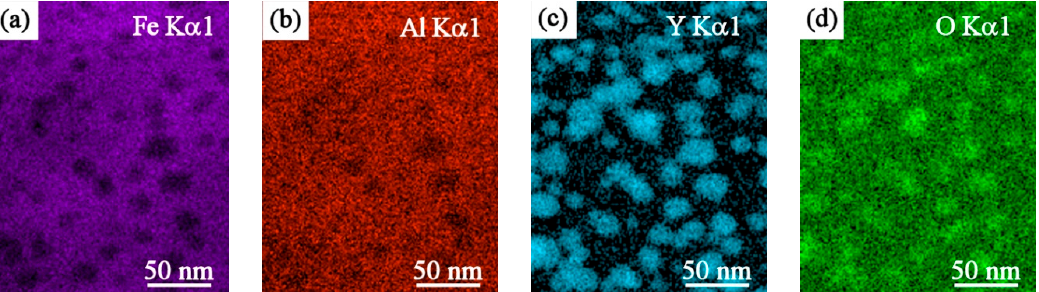
Figure 4. STEM-EDX mapping of reinforcing Y 2 O 3 nano-particles. The low contrast of Fe ( a ) and Al ( b ) mapping is due to their high content in the matrix and the foil thickness significantly exceeding the size of the yttrium-oxides ( c ). The low contrast of O ( d ) is due to the overlap of the O peak with peaks of other elements.